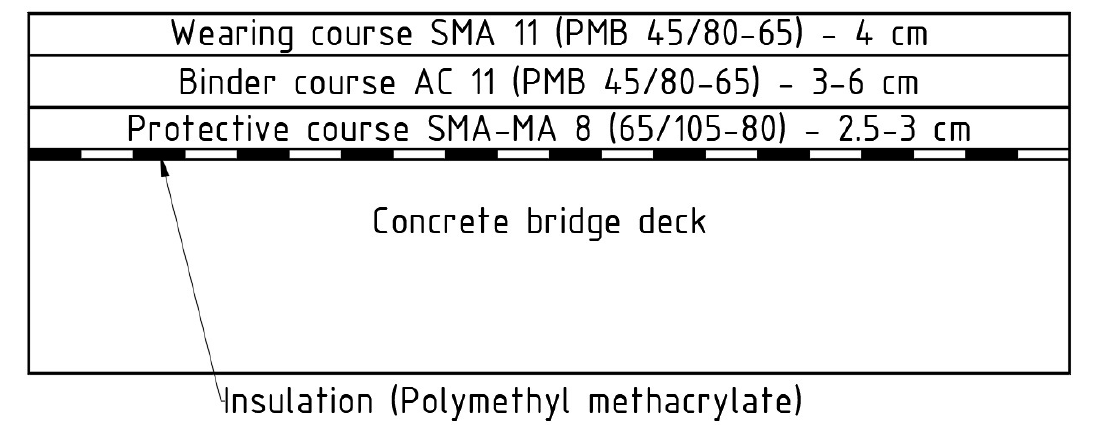
Figure 12. Pavement structure on the Trasa Zamkowa bridge .